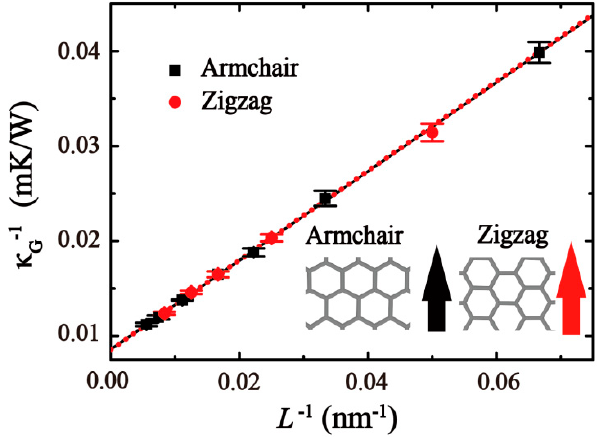
Figure 5. The relationship of length and thermal conductivity in GO ( R OH : ~10%) along zigzag (red) and armchair (black) directions at 300 K.